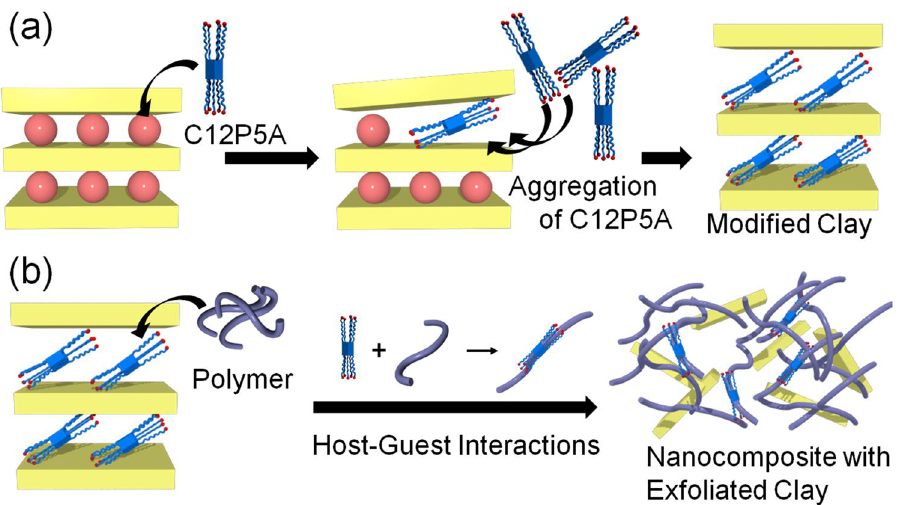
Figure 4. Proposed mechanism. ( a ) Clay intercalation using C12P5A and ( b ) clay exfoliation through host– guest interactions between C12P5A and poly(ethylene glycol) (PEG) within the